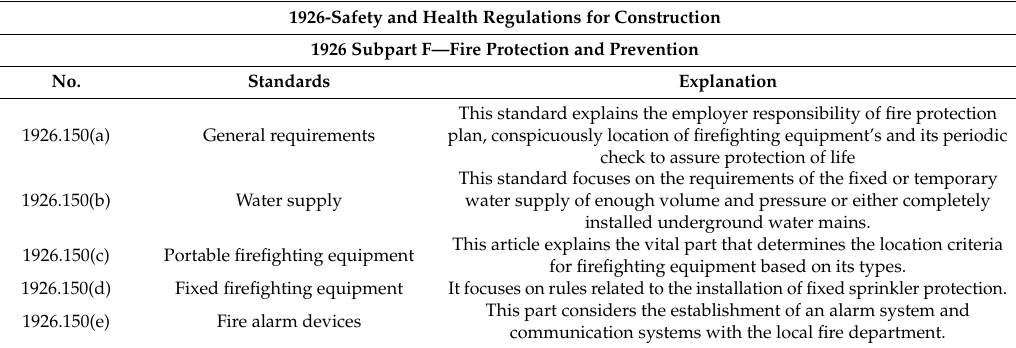
Table 1. Fire Protection and Prevention related to OSHA